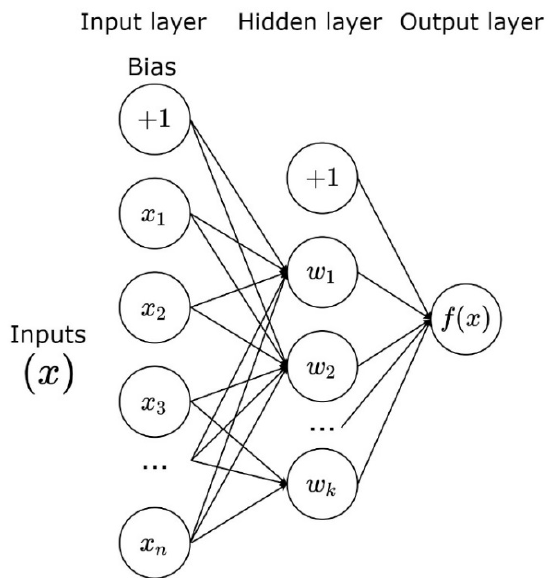
Figure 2. Schematic of a multilayer perceptron model (MLP). (Source: author).